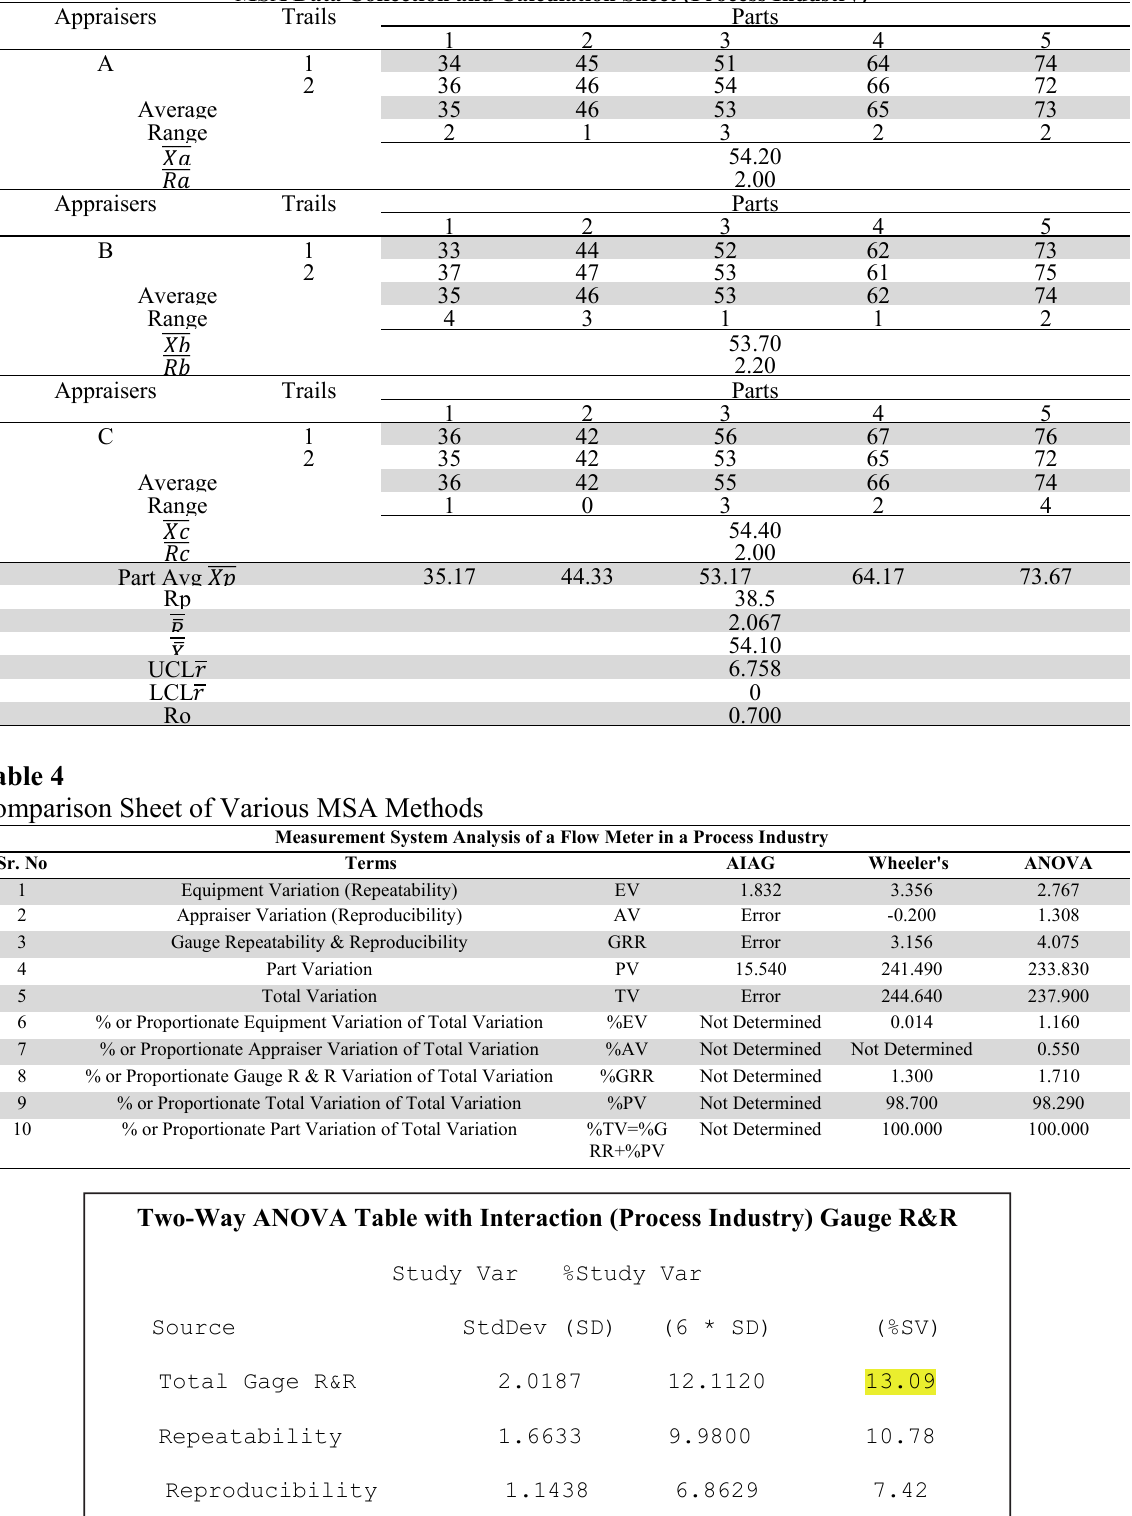
Data Collection Sheet (Process Industry) MSA Data Collection and Calculation Sheet (Process Industry) Appraisers